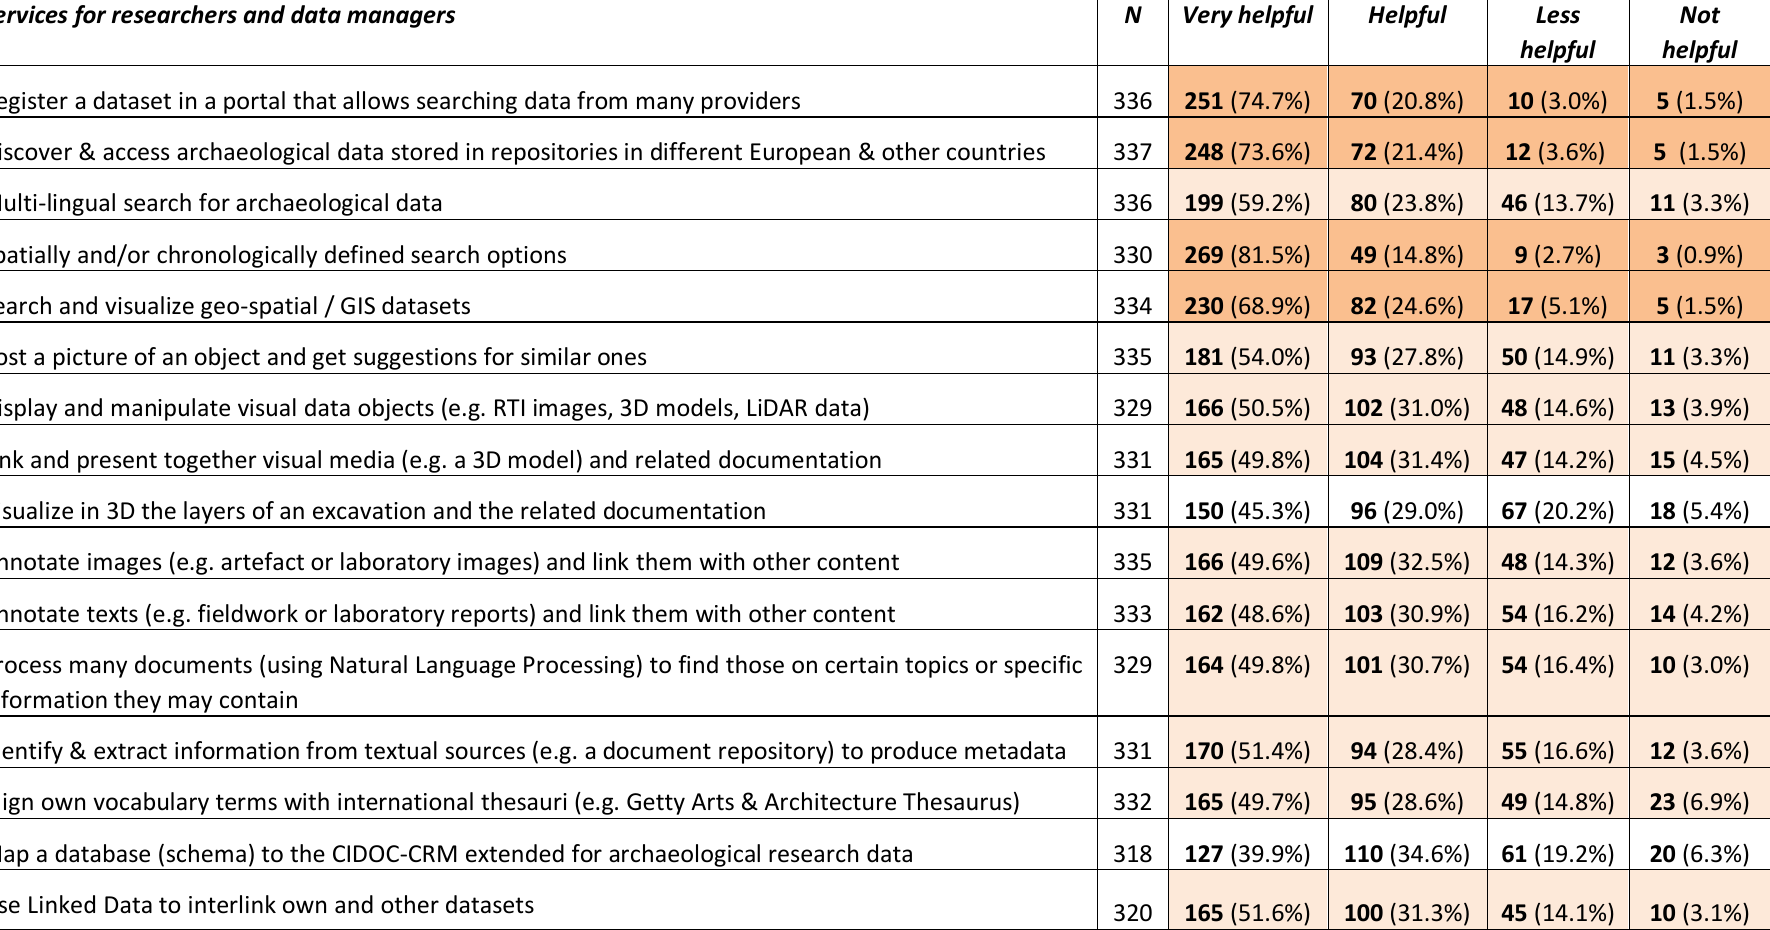
Table 22.2 : Services for researchers and data managers: overview of survey results (N =